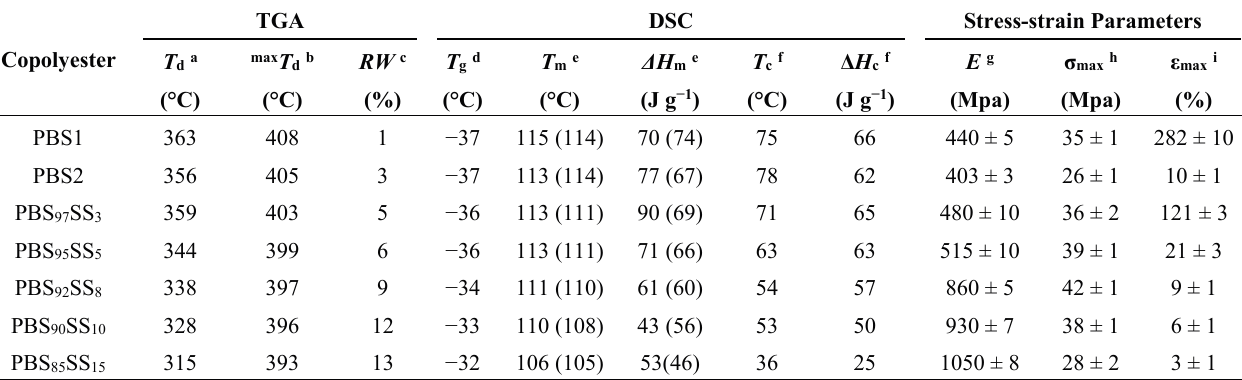
SS copolyesters. x y